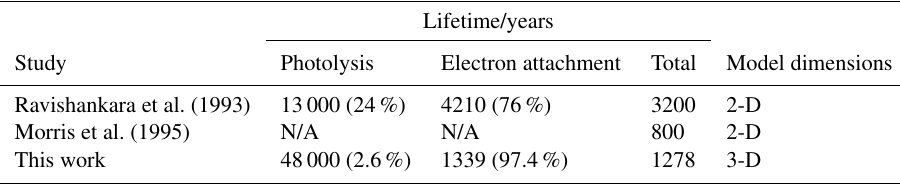
Table 3. Partial (reactions with electrons, photolysis and metals; K, Na) and total atmospheric lifetimes (years) of SF 6 from different studies. Numbers in parentheses show relative percentage contributions of loss due to the different